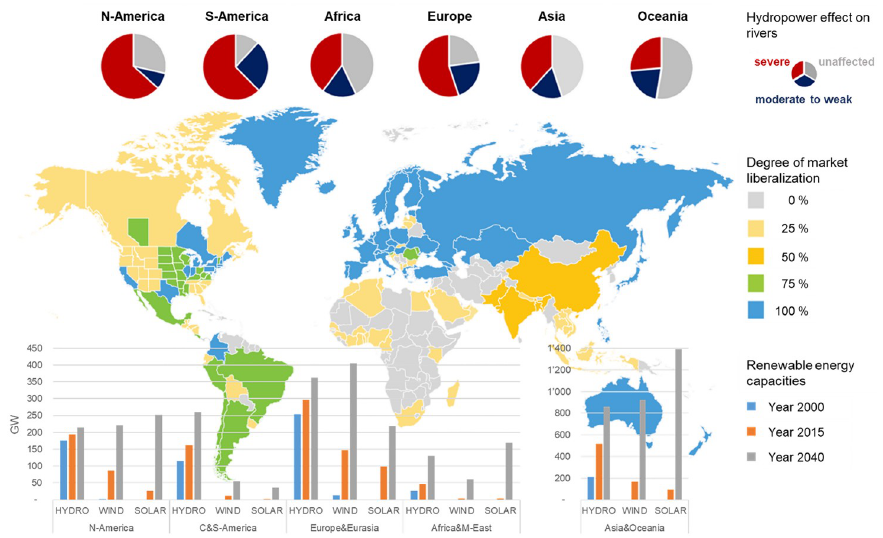
Fig 1. Global impact of hydropower on river systems, electricity market structures, and renewable capacity development. A degree of market liberalization of 0% means full regulation while 100% means full competition. Sources: Global flow regime threat from ref. [6]; electricity market structures based on ref. [10]; renewable capacity from ref. [7, 8]. World map in the background reprinted from “IEA. Re-powering Markets: Market design and regulation during the transition to low-carbon power systems: Electricity Market Series. 2016. All rights reserved.” [10] under a CC BY license, with permission from IEA, original copyright 2016. Disclaimer: This map is without prejudice to the status of or sovereignty over any territory, to the delimitation of international frontiers and boundaries and to the name of any territory, city or